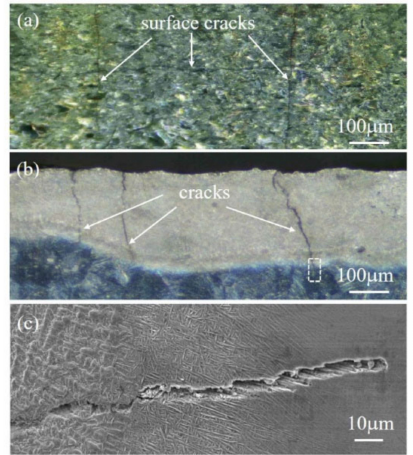
Figure 13. Cracking of the nitrided layer attained in the pure (100%) nitrogen atmosphere. ( a ) Surface cracking. ( b ) Cracking distribution through the layer. ( c ) Longitudinal cracking, the area illustrated by the dotted box in ( b